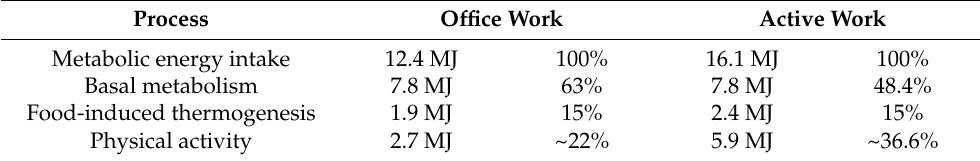
Table 1. Energy expenditure for metabolic processes according to lifestyle (person weight 80 kg).